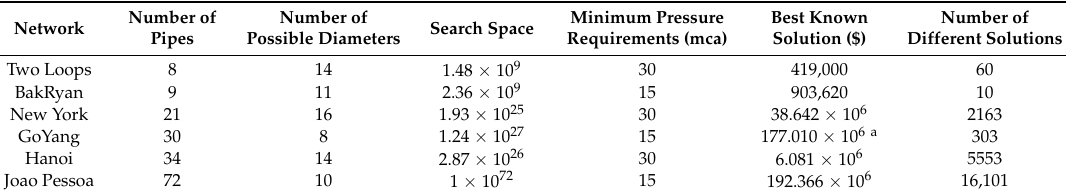
Note: a Cost in won (1000 won ≈ 1